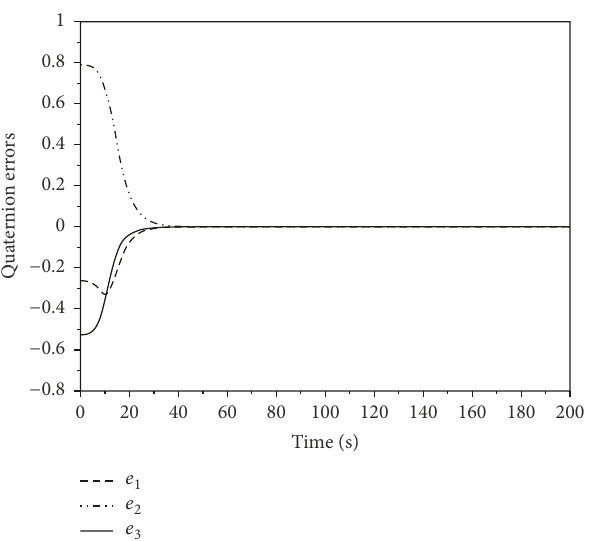
Figure 8: Quaternion errors under controller (50).